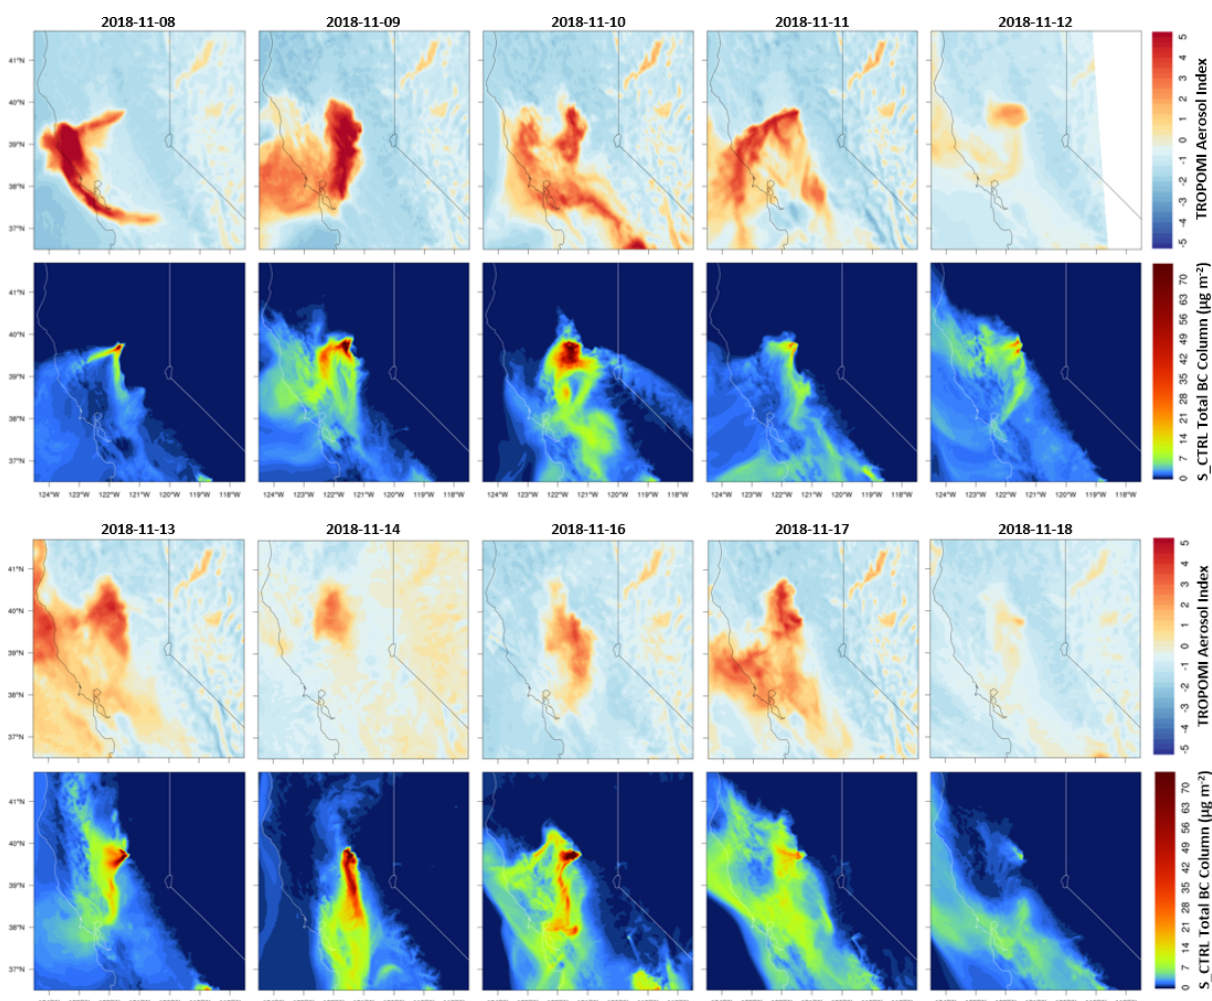
Figure 8. Comparison of TROPOMI UV aerosol index and S_CTRL total BC column during 8–18 November at 13:30LT as a proxy for plume structure and motion. Due to cloud coverage, no data for 15 November are shown. Positive aerosol index (warm colors) indicates aerosols that absorb radiation like black and brown carbon. The spatial distribution of the plume is generally captured on most days. The simulation also captures some of the finer structures seen by the satellite, though they are somewhat